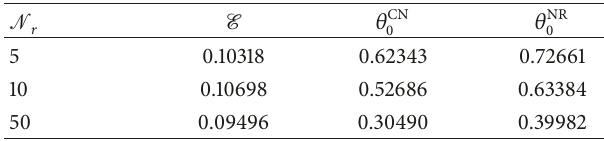
Table 4: Maximum error computed between the respective numer- ical solutions obtained, where E = max | CN CN sol − CN NR sol | , and their respective temperatures at the tip of the fin, given as 𝜃 0 , for varied values of 𝑟 ∗ .